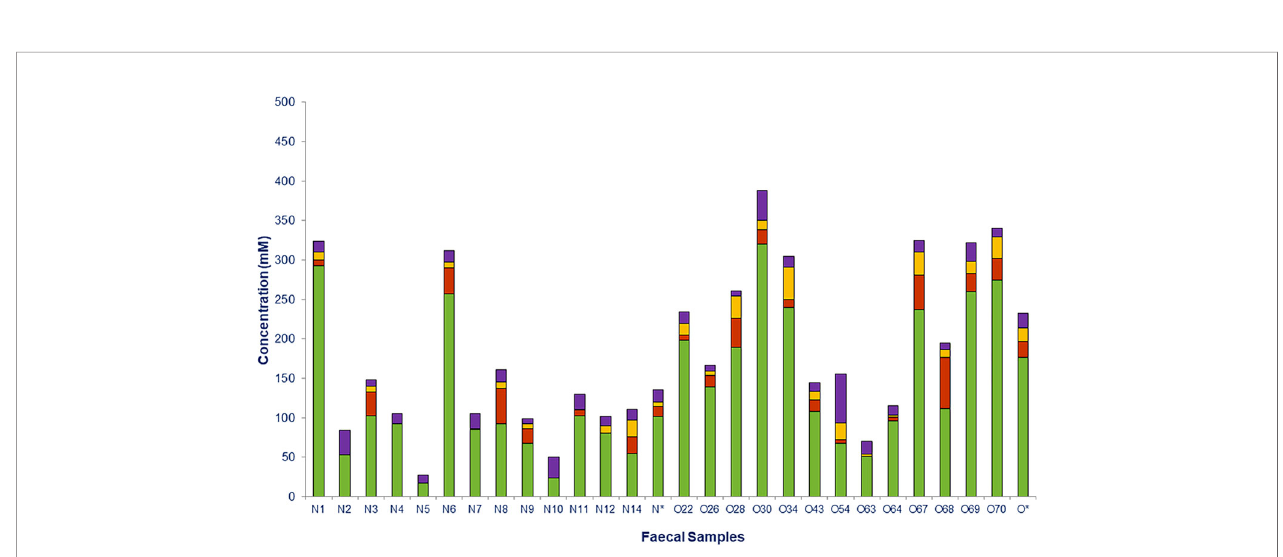
FIGURE 6 | Short chain fatty acids (SCFAs) and lactate measured in fecal samples from normoweight (N) and obese (O) individuals: acetate ( ), propionate ( ), butyrate ( ), and lactate ( ). The column (*) represents the median value of each